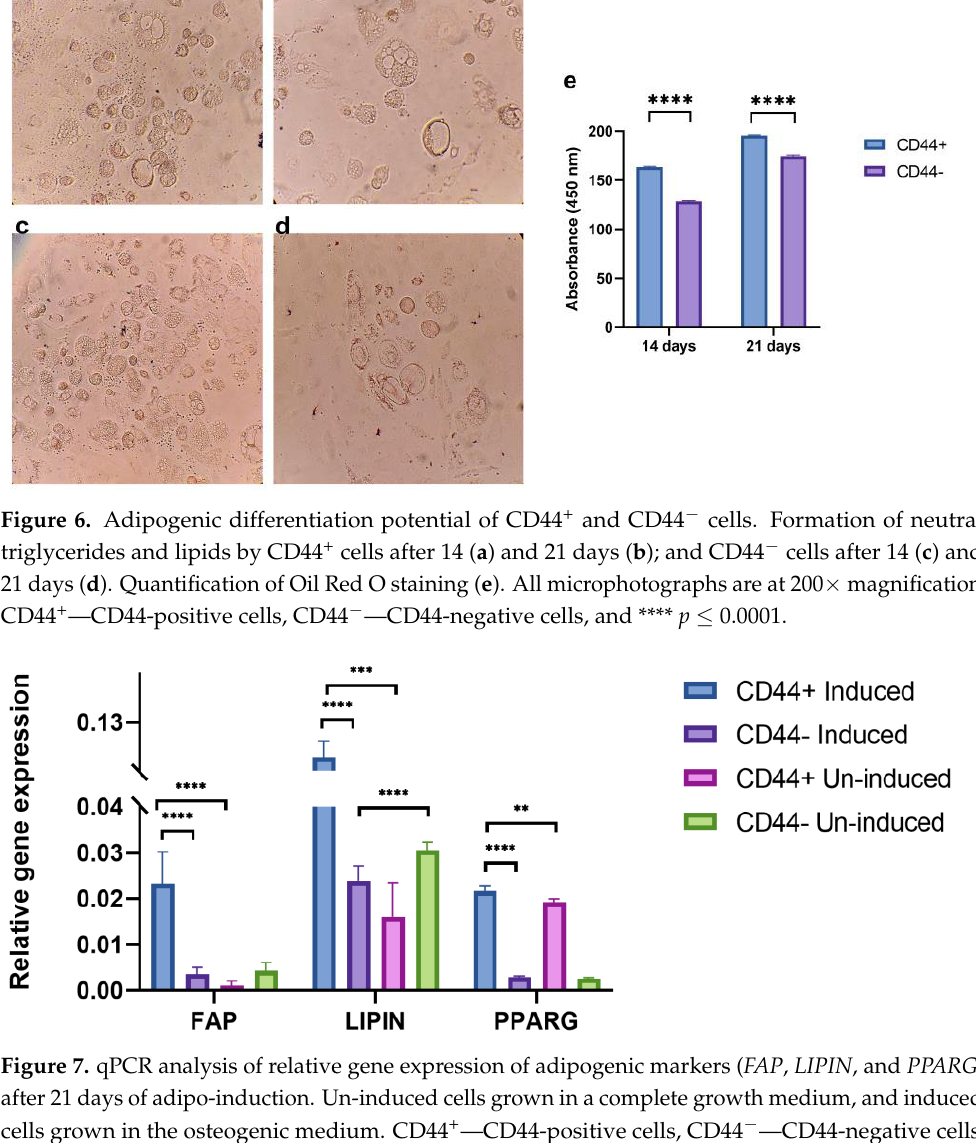
Figure 8. qPCR analysis of relative gene expression of adipogenic markers during 21 days of adipo-induction. FAP ( a ), LIPIN ( b ), and PPARG ( c ) relative expression levels in CD44 + cells.